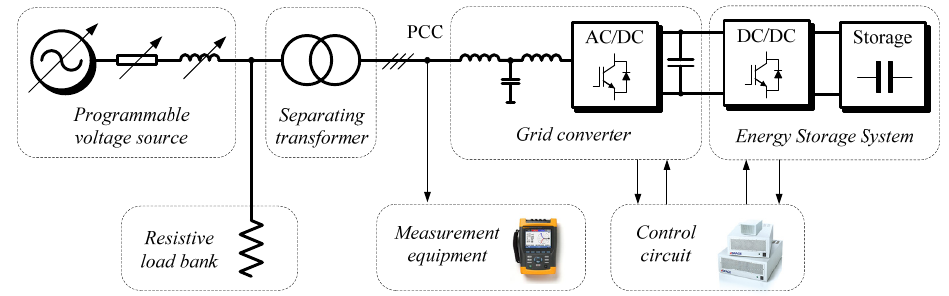
Figure 9. Scheme of laboratory setup.